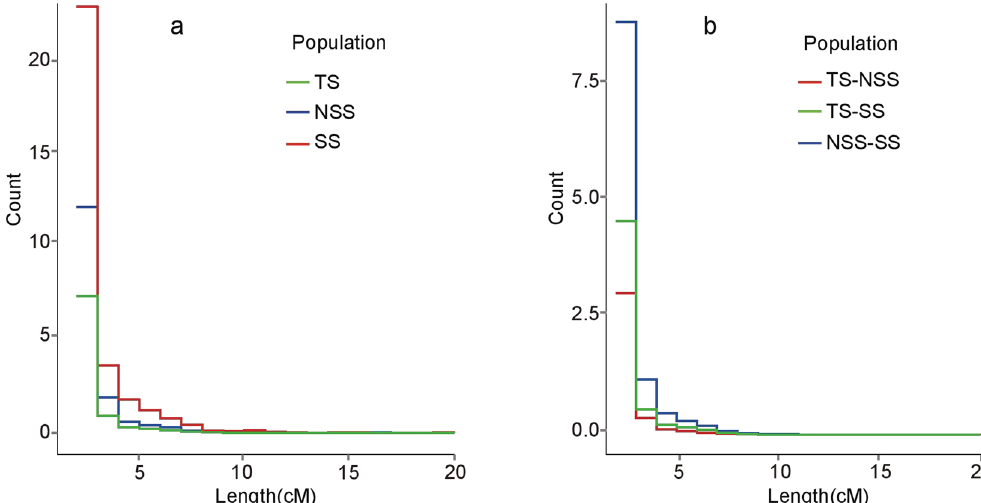
Figure 4. The length distribution of IBD tracts within populations ( a ) and across populations ( b ). The number of IBD tracts are normalized by the number of individuals (in a ) or individual pairs (in b ).